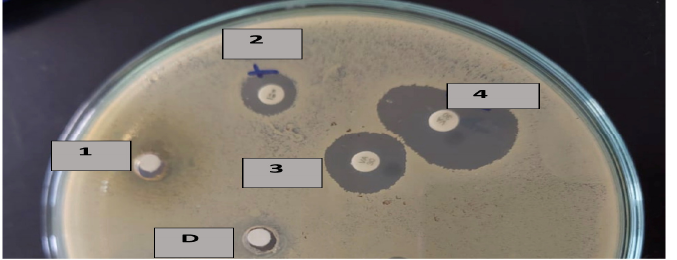
Figure 2. Inhibition zones of D: DMSO for 1: luteolin 4 (cid:48) -neohesperidoside (L4N) alone, 2: penicillin Figure 2 . Inhibition zones of D: DMSO for 1: luteolin 4 ′‐ neohesperidoside (L4N) alone, 2: penicillin combined with L4N, 3: vancomycin alone, and 4: vancomycin combined with L4N. combined with L4N, 3: vancomycin alone, and 4: vancomycin combined with L4N. The MIC values of L4N against the tested Enterobacteriaceae were 26.66 µ g/mL for The MIC values of L4N against the tested Enterobacteriaceae were 26.66 μ g/mL for STEC and 53.33 µ g/mL for MDR K. pneumoniae (Table STEC and 53.33 μ g/mL for MDR K. pneumoniae (Table 3). Table 3. MIC of luteolin 4 ′‐ neohesperidoside (L4N) against MDR E. coli O 111 and MDR K. pneumoniae .